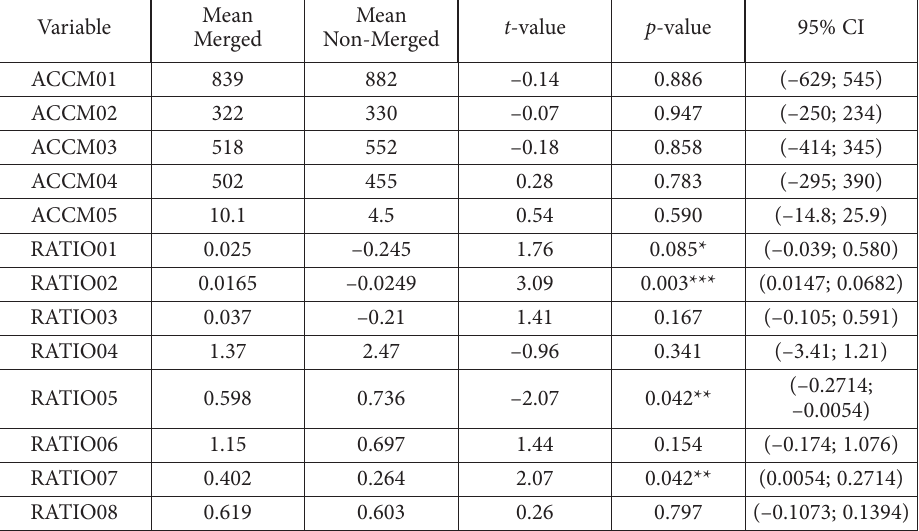
Table 4a. Comparison results (with mean) of merged and non-merged firms (sample and control sample) Mean Mean t -value p Variable Merged Non-Merged